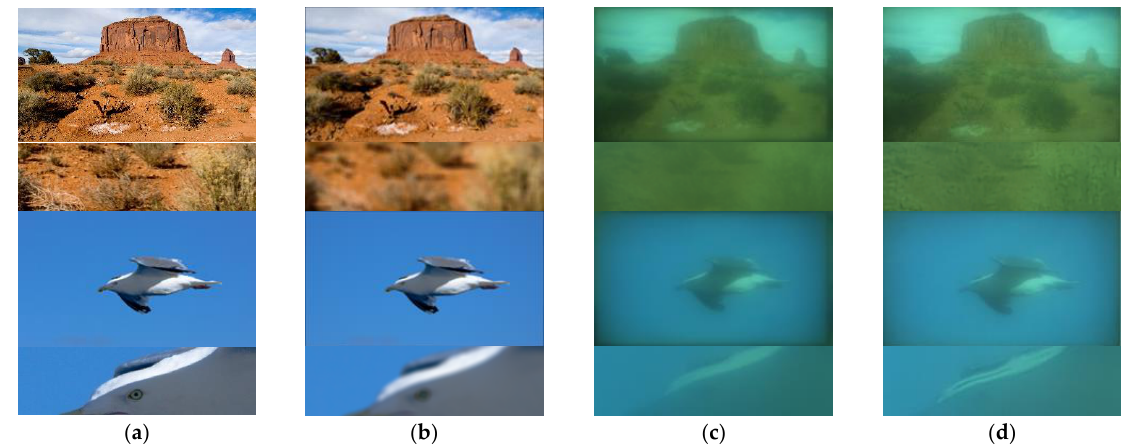
Figure 7. Network restoring results based on simulation dataset fails in real scene test: ( a ) Original sharp images; ( b ) Blurry images simulated by CODE V; ( c ) The real blurry images directly captured by simple lens imaging system; ( d ) The restoring results from ( c ) using the parameters trained by CODE V simulation data set.